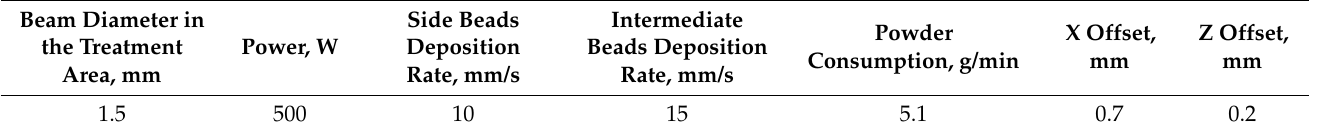
Table 2. Direct laser growth parameters [9].